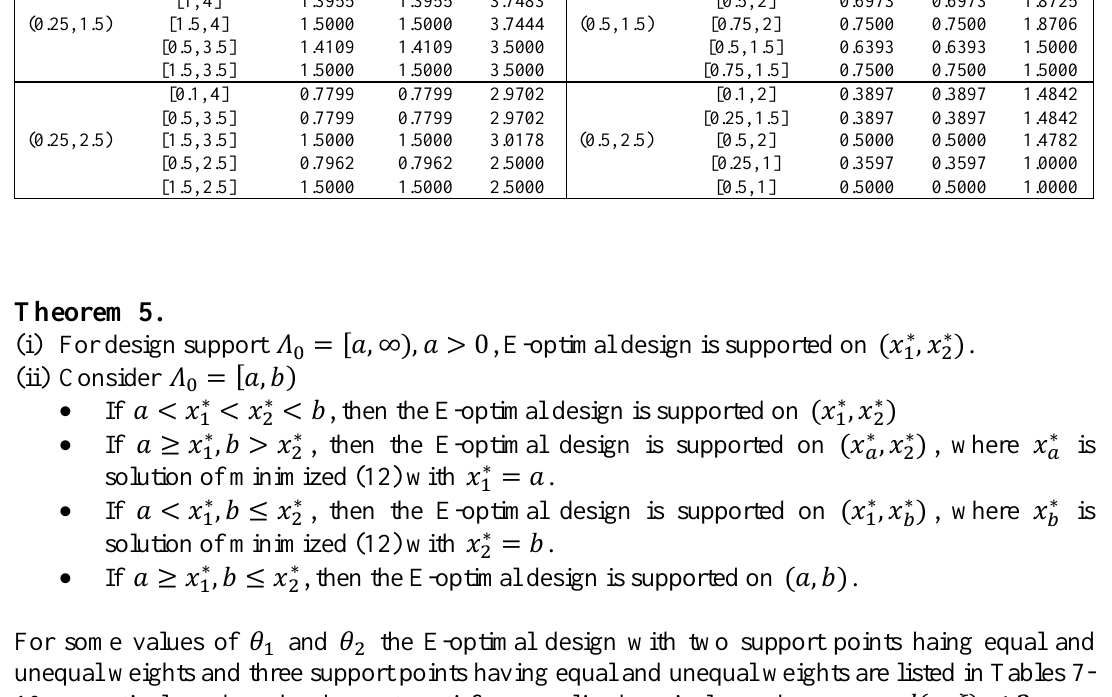
Table 6. A-optimal designs for generalized Pareto model with three support points having weights